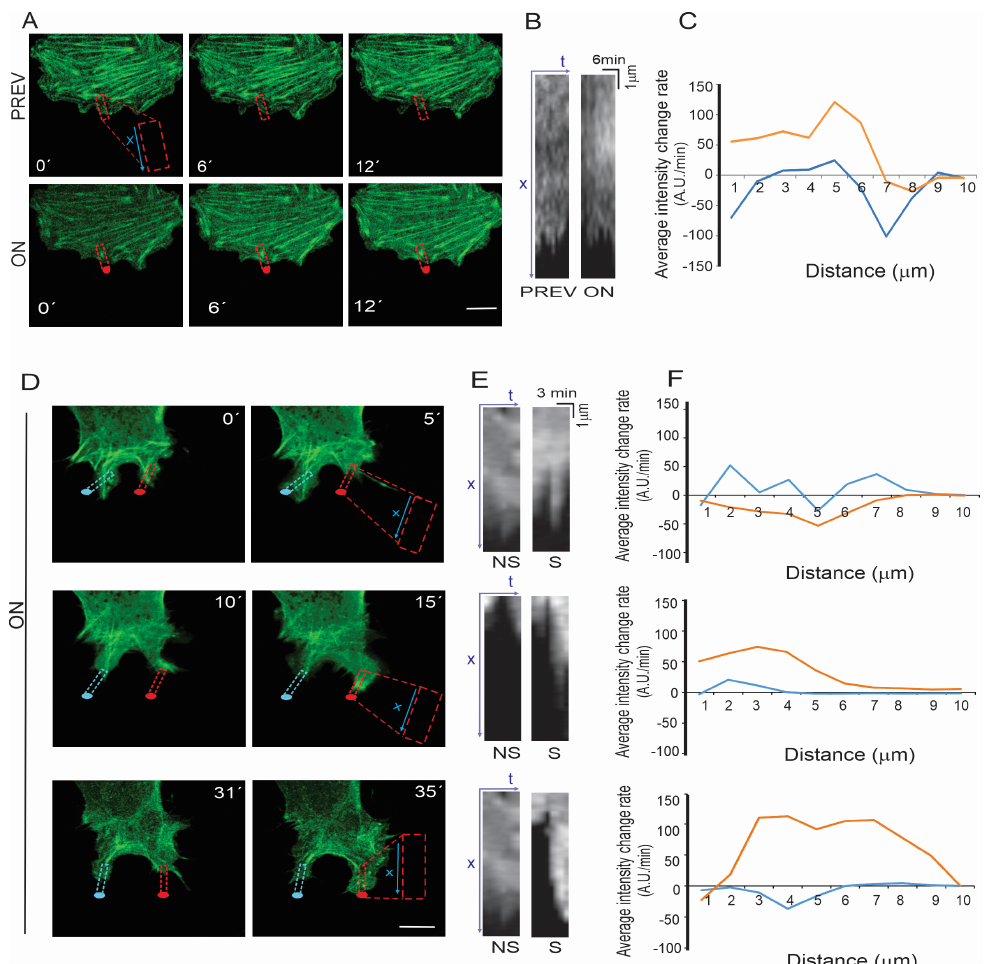
Figure 6. Effects of laser stimulation on actin-GFP. ( A ) Selected images of a 3T3 cell expressing actin-GFP during 12 min previous to its stimulation (PREV) and while laser-stimulated (ON). Red dots indicate the position of the laser spot during the ON period. Dotted lines indicate the rectangular area selected for the kymograph analysis. Widened copies of the red rectangles are shown to indicate the axis of the position dimension (X) of the kymographs. ( B ) Kymographs obtained from the cell area adjacent to the laser spot (ON) or from an equivalent area during the period of time without the laser stimulation (PREV). ( C ) Temporal fluorescence intensity change in the kymographs averaged over the observation period (0–12 min), as a function of the position along the x axis along the region of interest shown by the dashed rectangles. The non-stimulated condition is represented by a blue line, while the orange line corresponds to the laser-stimulated condition. ( D ) Selected images of a 3T3 cell expressing actin-GFP under laser stimulation (ON). Laser spot (red dots) was displaced, while the cell advanced at different time intervals. Red dotted lines indicate the selected areas for the kymograph computations at the time periods when the cell was projecting (0–5, 10–15, and 31–35 min). Widened copies of the red rectangles are shown to indicate the axis of the position dimension (X) of the kymographs. Blue dotted lines indicate an equivalent area in the same cell without laser stimulation. ( E ) Kymographs obtained from non-stimulated (NS) or laser stimulated areas (S). ( F ) Similar to C , for the kymographs shown in ( E ). Scale bars in ( A ) and ( D ) correspond to 10 µ